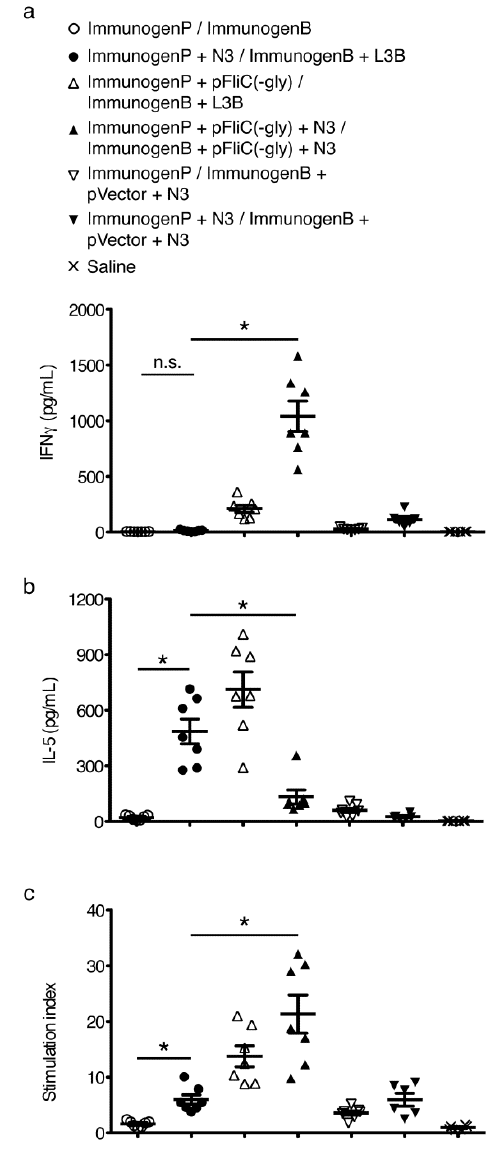
Figure 9. Analysis of T cell responses to immunizations with p24gag with and without adjuvant combinations. ( a ) Anti-mIFN ELISA was performed on cells restimulated with p24gag. Values shown were adjusted for baseline values seen using identical stimulations using splenocytes from naïve mice. Priming (ImmunogenP, plasmids) and boosting (ImmunogenB, rec proteins) groups are shown in the key. Immunization details are listed in Table 2; ( b ) Anti-mIL-5 ELISA was performed on cells restimulated with p24gag. Values shown were adjusted for baseline values seen using identical stimulations using splenocytes from naïve mice; ( c ) Proliferative response to stimulation with p24gag defined as stimulation index relative to identical stimulations using splenocytes from naïve mice. Statistical analyses were conducted using a two-tailed unpaired Student t test. * Differences of the responses between compared groups at week 4 after final boost defined as p ≤ 0.05 were considered significant. n.s. = non-significant. Comparisons between groups with the HIV-1 antigens were performed by using the non-parametric Mann-Whitney U test with Bonferroni correction, p < 0.05 was considered